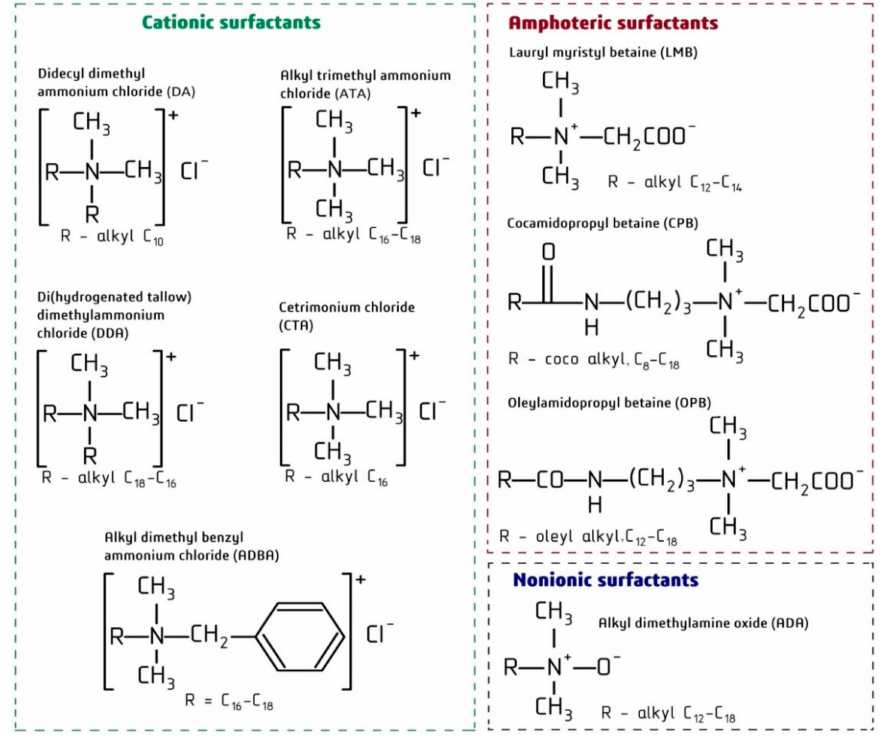
Figure 1. Chemical structures of the used